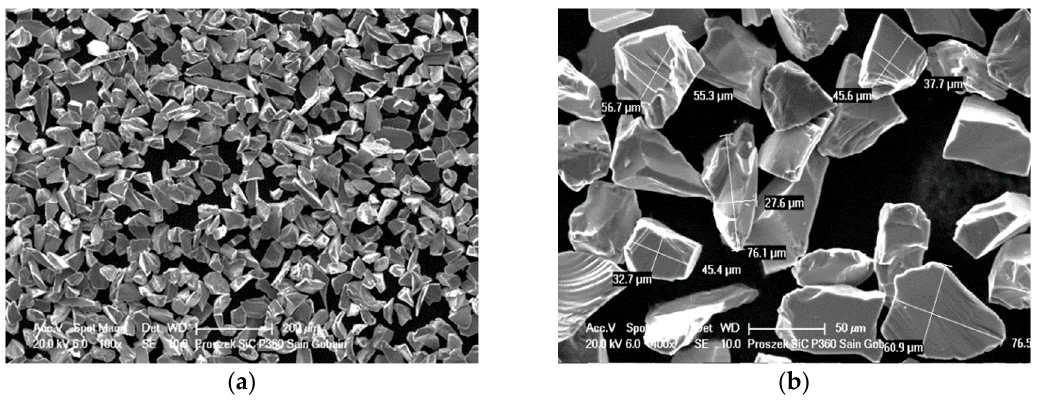
Figure 2. Scanning electron microscopy (SEM) images showing the morphology of irregular silicon carbide particles (SiC p ).